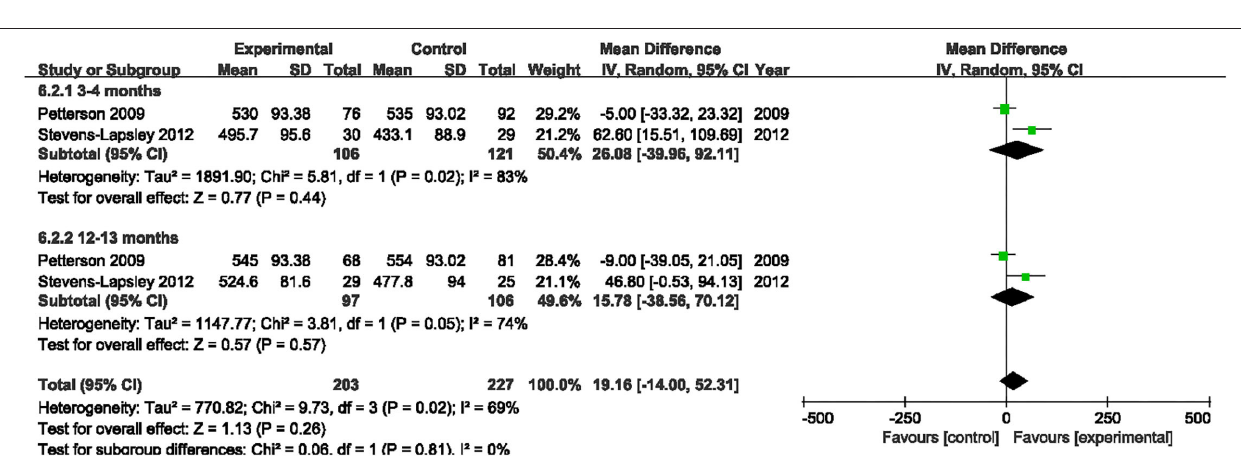
FIGURE 11 | Forest plots of meta-analysis of the effect of NMES vs. conventional rehabilitation on 6-minute walk test.